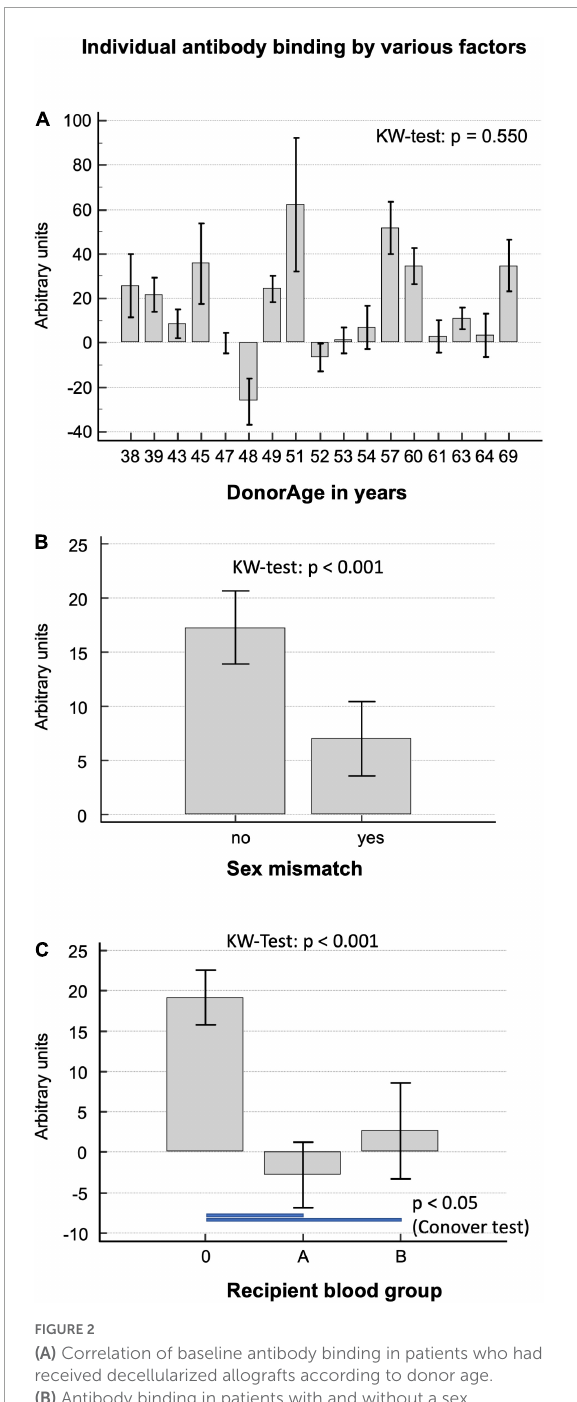
FIGURE3 (A) Individual antibody binding of each patient against 12 solubilized decellularized valves. The lines connect the averages of all triplicate medians, displayed as arbitrary units, of each patient. The black line shows the average antibody binding of the whole study cohort at the respective time points. (B) Individual antibody binding for all 20 patients differentiated by age, valve position, prior DHV implantation, and echocardiographic signs of early degeneration. Broken lines indicate the patient post-lung